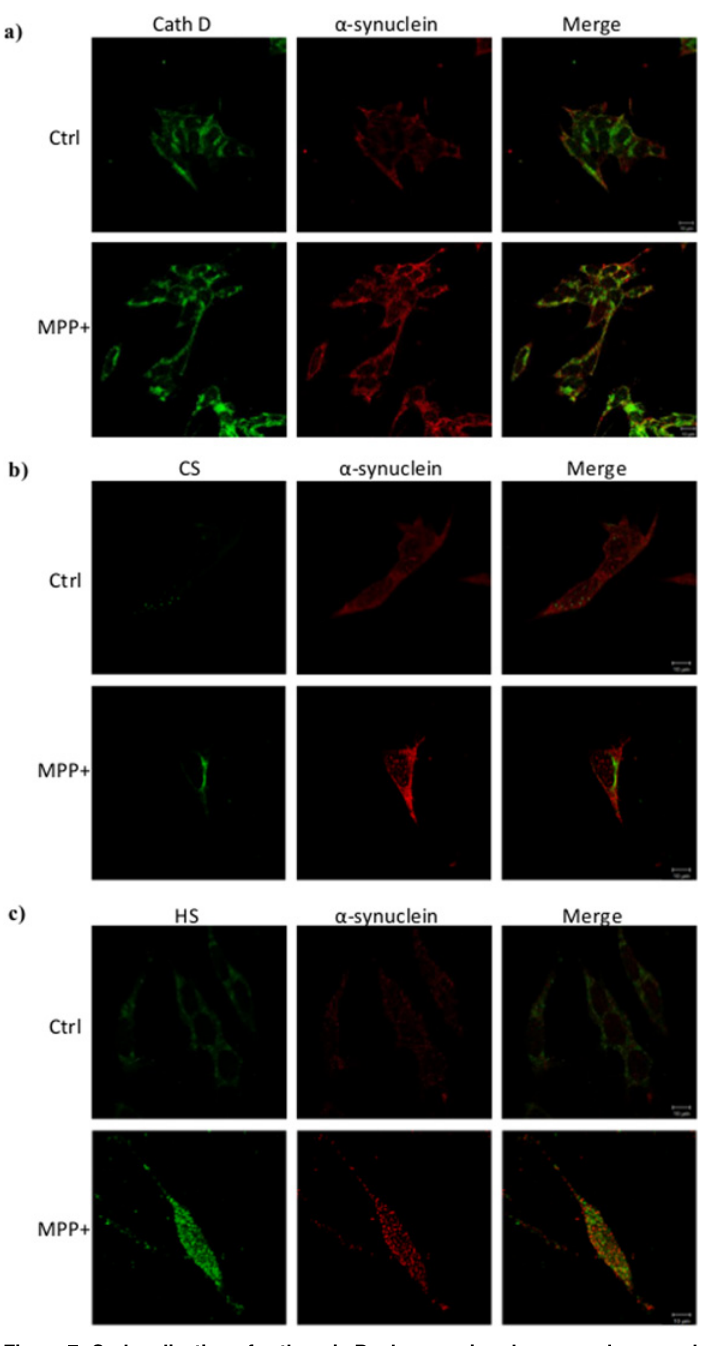
Figure 7. Co-localization of cathepsin D, glycosaminoglycans and α -synuclein in MPP + -stressed cells. a) Immunofluorescence detection of CathD (green) and α -synuclein (red) in unstressed (Ctrl) and MPP + -stressed cells (6 h). b) Immunofluorescence co-labeling of CS (green) and α -synuclein (red) in normal (Ctrl) and MPP + -stressed cells (6 h). c) Immunofluorescence co-labeling of HS (green) and α -synuclein (red) in normal (Ctrl) and MPP + -stressed cells (6 h). Observations were done with a confocal microscope Zeiss Axio Observer Z.1. Stars and arrows indicate areas where co-localization is observed.